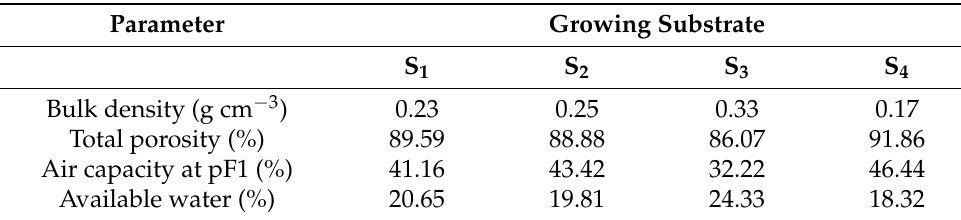
Table 1. Physical properties of substrates. Average values are